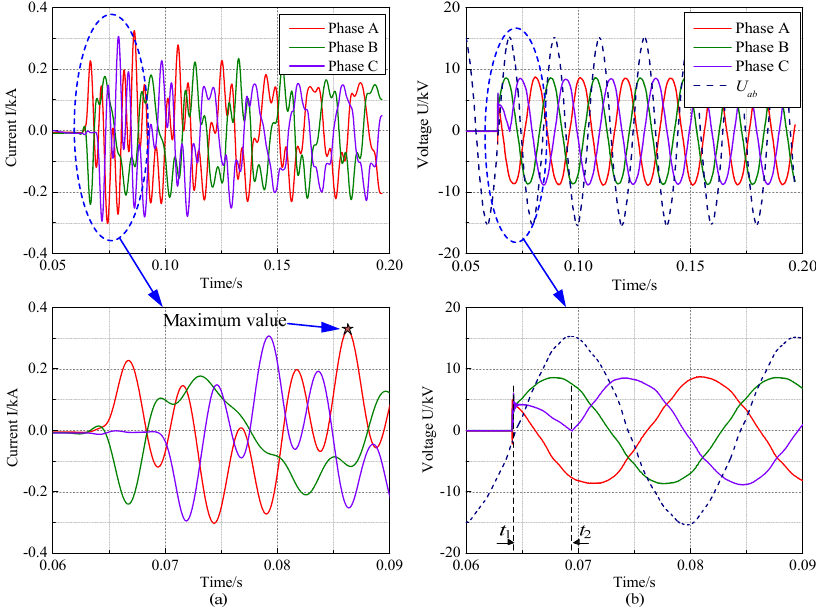
Figure 10. Waveforms of the closing current and capacitor voltage in Case 3. ( a ) Current waveform; and ( b ) voltage waveform.